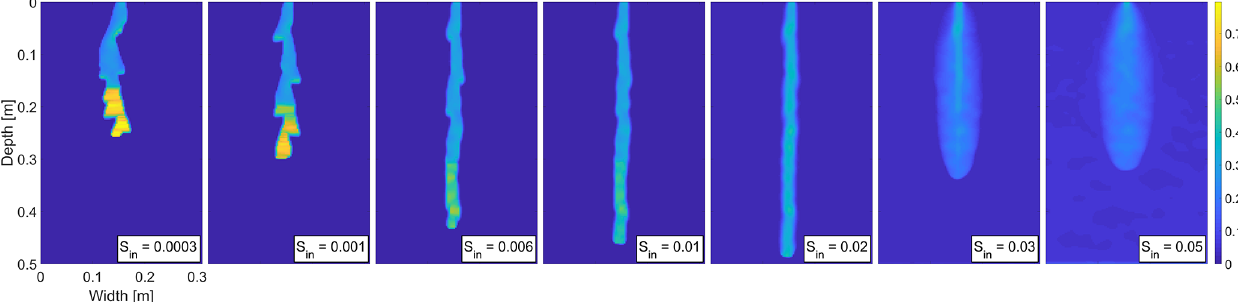
Figure A5. Snapshot of the saturation field at 25min for seven different values of the initial saturation for the distribution which satisfies κ max /κ min ≈ 3 . 40 (the distribution in Fig. A2c). Saturation values are color coded according to the color bar on the right.